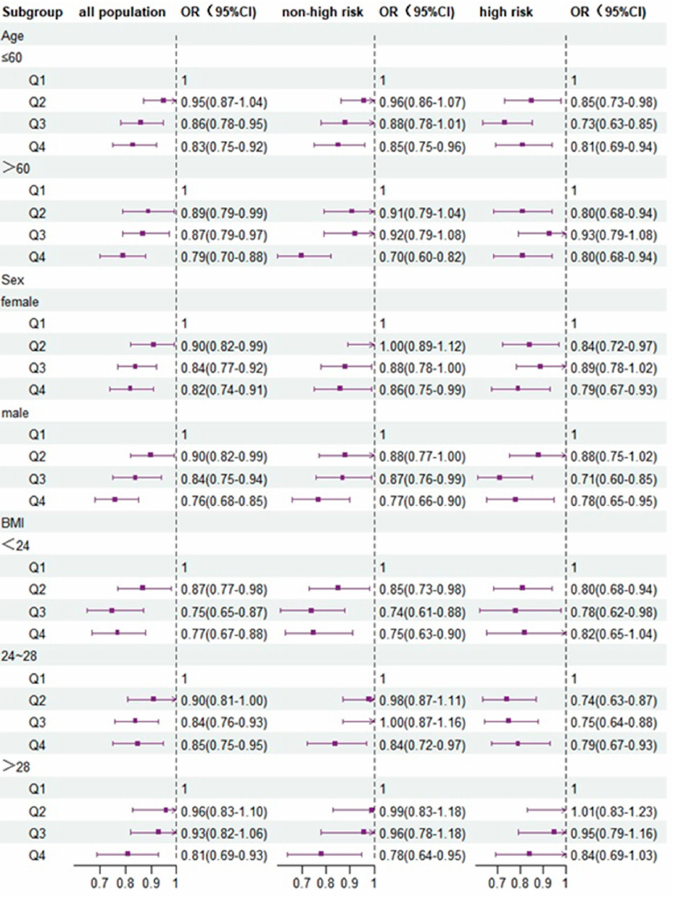
Figure 3. Odds ratios (ORs) and 95% confidence intervals (CIs) for T2D risk according to PDI quar- tiles stratified by age, sex and BMI adjusted for a series of covariates in Model 3 compared with PDI Q1. Non-high risk, non-high cardiovascular risk population. High risk, high cardiovascular risk